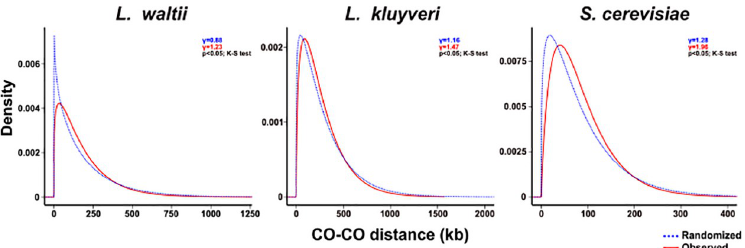
Fig 5. Interference in L . waltii . A gamma law fit of the distribution of distances between pairs of adjacent crossovers is represented compared to a randomized distribution of COs across tetrads. Gamma parameters were as follows: for L . waltii , γ = 1.23 and ⍬ = 145.9, for S . cerevisiae , γ = 1.96, ⍬ = 61.7 and for L . kluyveri , γ = 1.47, ⍬ = 187. γ represents the shape parameter and ⍬ represents the scale parameter. Distribution of inter-crossover distances depicted in S8 Fig.